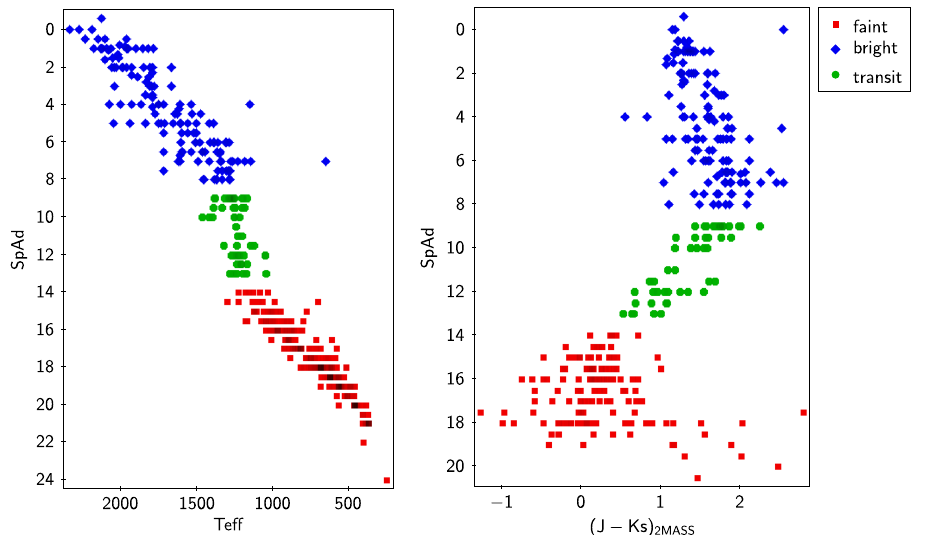
Figure 2: Photometric, color, and spectral characteristics of three families, objects. Bright objects are indicated in blue, transit in green, and faint in